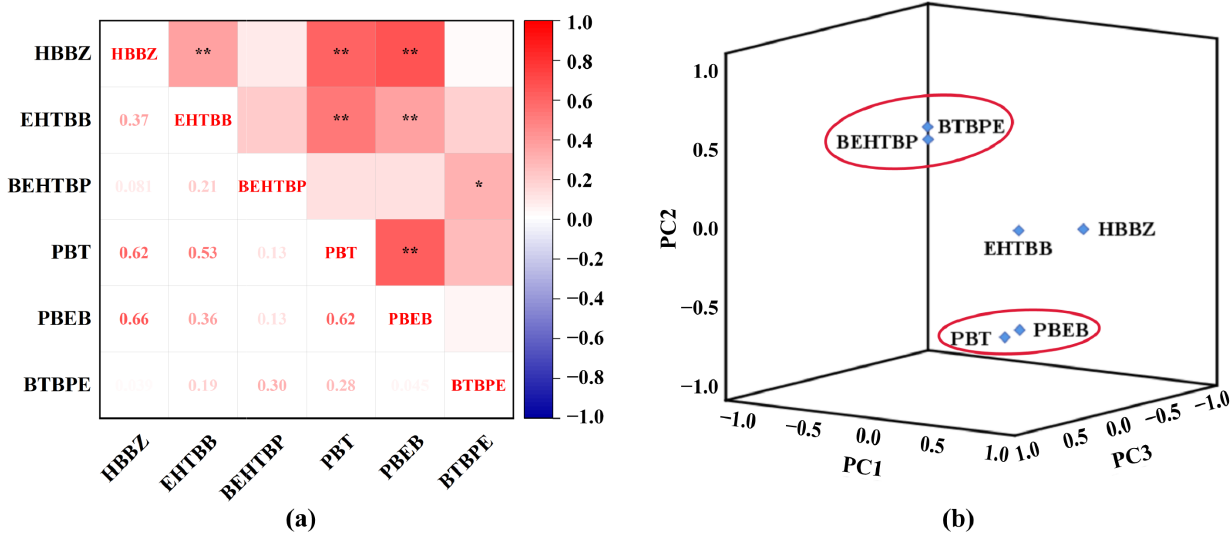
Figure 3. Spearman correlation coefficient among concentrations of NBFRs in dust samples from e-waste-dismantling workplace (* p < 0.05; ** p < 0.01) ( a ), and principal component analysis of NBFRs in dust samples from e-waste-dismantling workplace (PC1, 36.0% variance; PC2, 20.9% variance; PC3, 20.2% variance) ( b ).